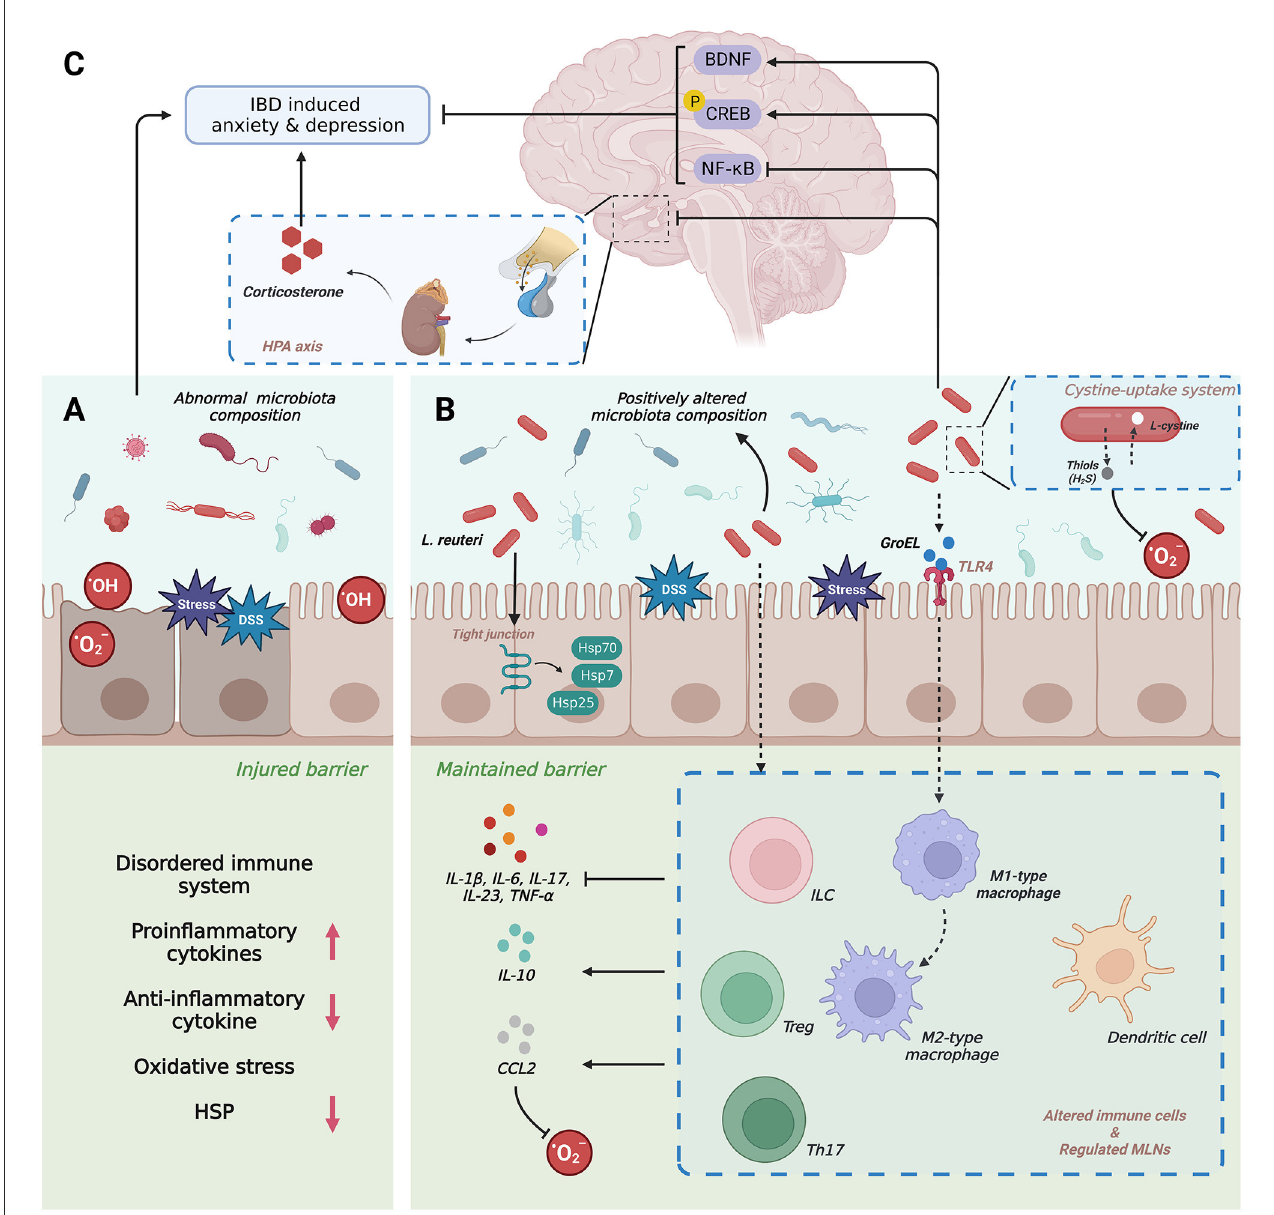
FIGURE1 (A–C) Schematic diagram depicting the pathogenic role and therapeutic potential of Lactobacillus reuteri in IBD. IBD, inflammatory bowel disease; BDNF, brain-derived neurotrophic factor; CREB, cAMP-response element binding protein; DSS, dextran sodium sulphate; HSPs, heat shock proteins; NF- κ B, nuclearfactor- κ B; IL, interlukin; TNF- α , tumor necrosis factor- κ ; CCL, C-C motif chemokine 2; Th, T helper cell; TLR, Toll-like receptors; ILC, innate lymphoid cells; Treg, regulatory T cell; MLN, mesenteric lymph